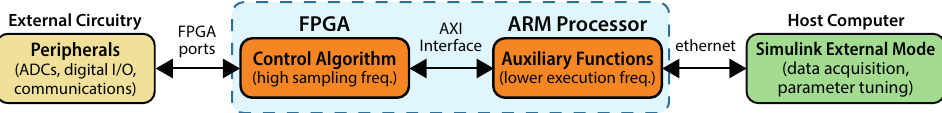
Figure 4. Proposed execution philosophy for power electronics control using Zynq-based devices.